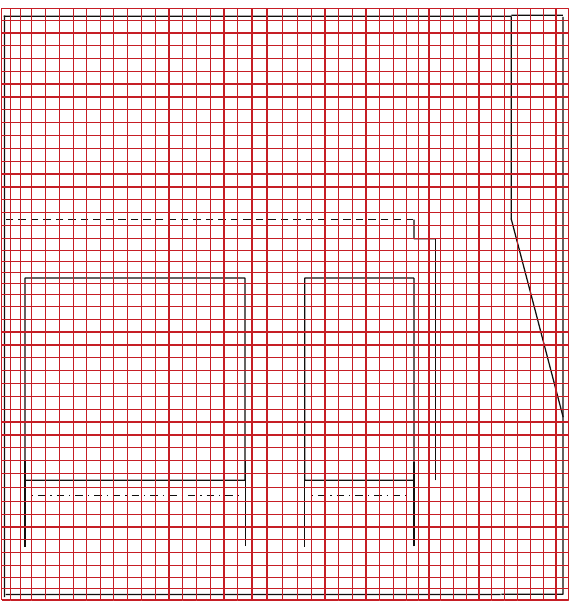
Figure 3: Nodalization of the SG